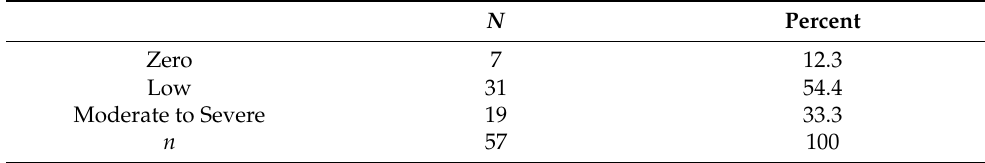
Table 6. Symptoms of PTSD from the Child PTSD Symptom